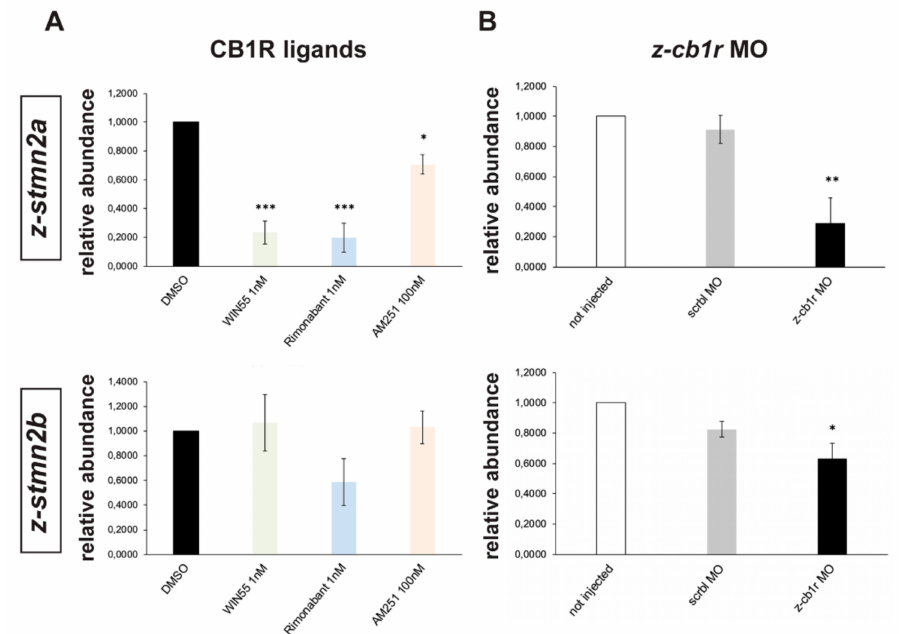
Figure 6. Expression of z-stmn2a and z-stmn2b upon treatment with CB1R ligands or CB1R knockdown in early zebrafish embryos. ( A ) Real-time qPCR analyses of z-stmn2a (top histogram) and z-stmn2b (bottom histogram) on RNA samples obtained from embryos treated with the indicated CB1R ligands, at the indicated doses. Expression is shown relative to the expression of the housekeeping mRNA ( z- β -actin ). The abundance of the control RNA (DMSO) was set to 1. A reduced abundance of z-stmn2a mRNA was observed in embryos treated with the ligands, as compared to embryos treated with DMSO only. ( B ) Same analysis as above, on RNA samples obtained from uninjected (open bars), scrambled MO-injected (solid grey bars) or z-cb1r MO-injected (solid black bars) embryos. A reduced expression of z-stmn2a and z-stmn2b mRNAs was observed in embryos injected with z-cb1r MO as compared to the controls. * = p < 0.05; ** = p < 0.01; *** = p <